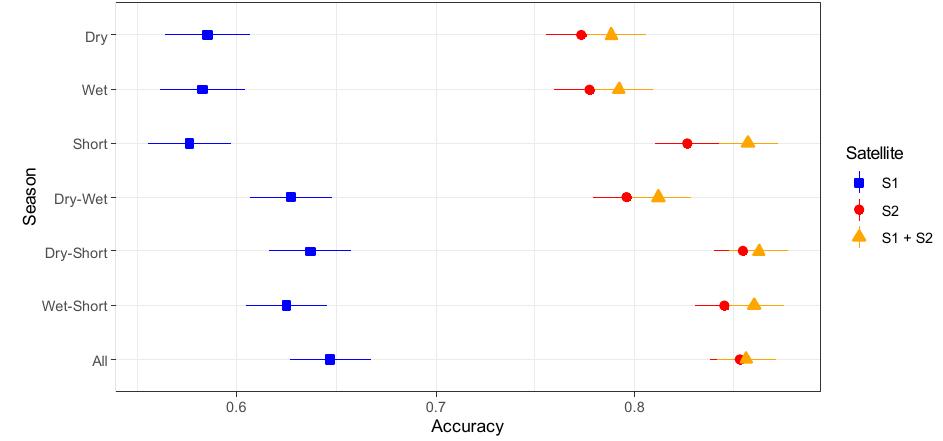
Figure 8. Overall accuracy results for the 21 models according to sensor and season combinations.